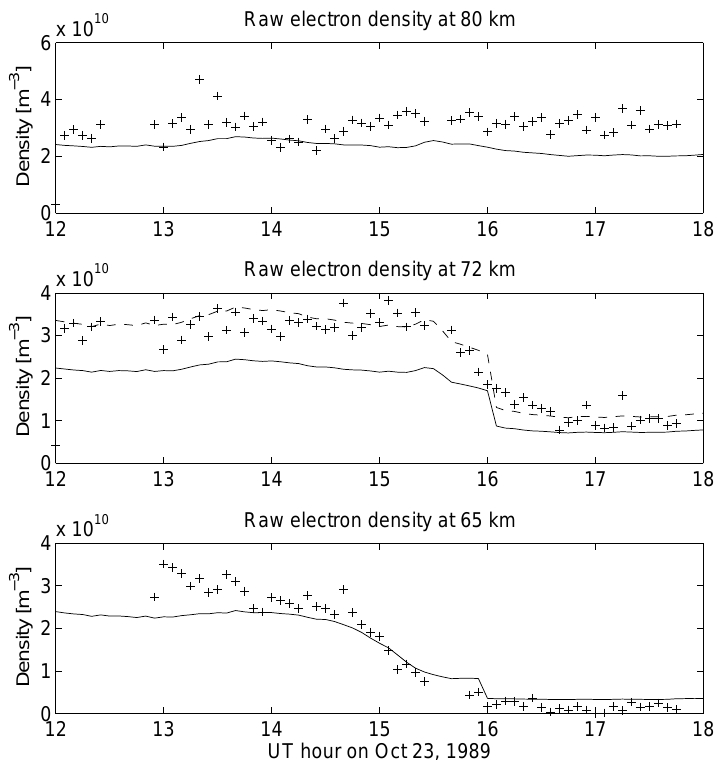
Fig. 10. Sunset behaviour of raw electron densities at selected altitudes from EISCAT measurements (+) and modelling (solid line). In the middle panel, the model values multiplied by 1.5 are shown (dashed line) to aid the comparison with the measured